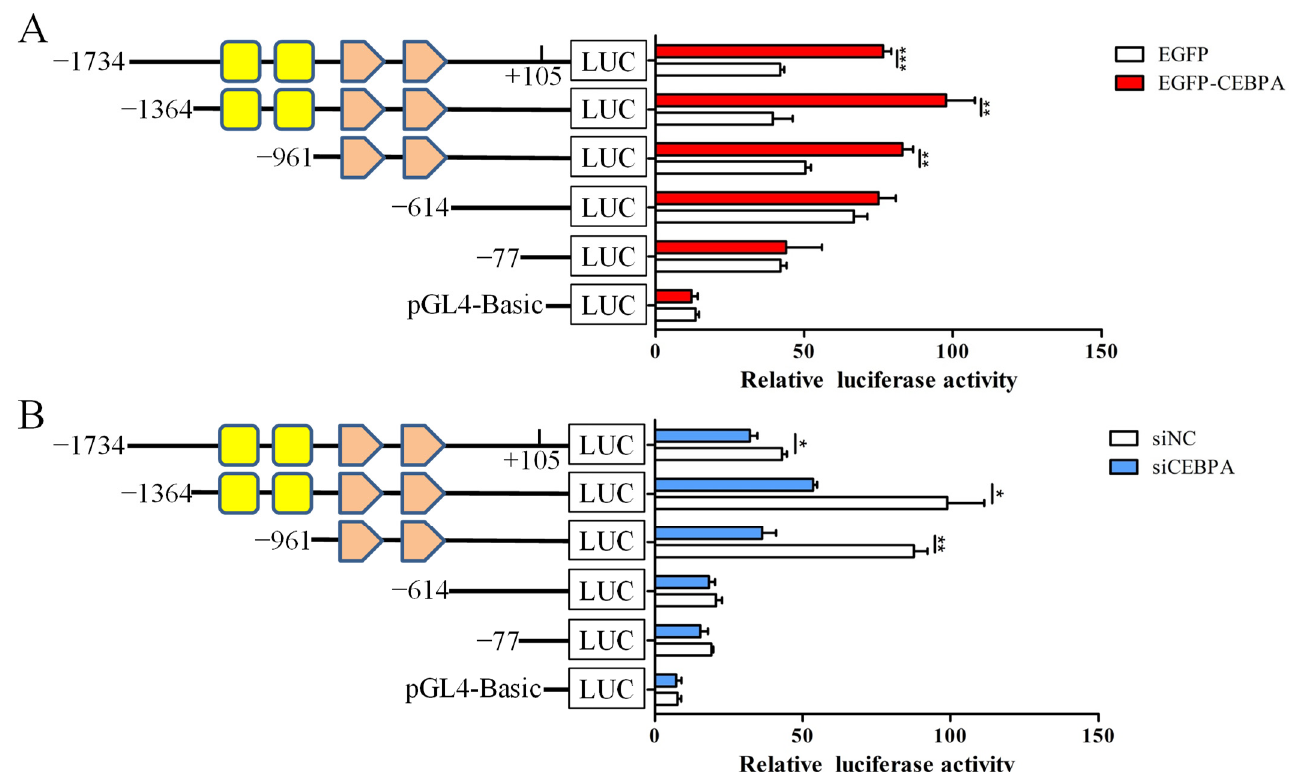
Figure 7. Identification of the cis -regulatory elements of CEBPA regulating the transcriptional activity of buffalo SOCS1 in BuMECs. ( A ) The effect of CEBPA overexpression on the activity of SOCS1 promoters of different lengths. ( B ) The effect of CEBPA knockdown on the activity of SOCS1 promoters of different lengths. Yellow rectangles represent CEBPA binding sites and orange pentagons represent NF- κ B binding sites. Data are presented as means ± SEM for three individual cultures; * p < 0.05, ** p < 0.01, *** p < 0.001.